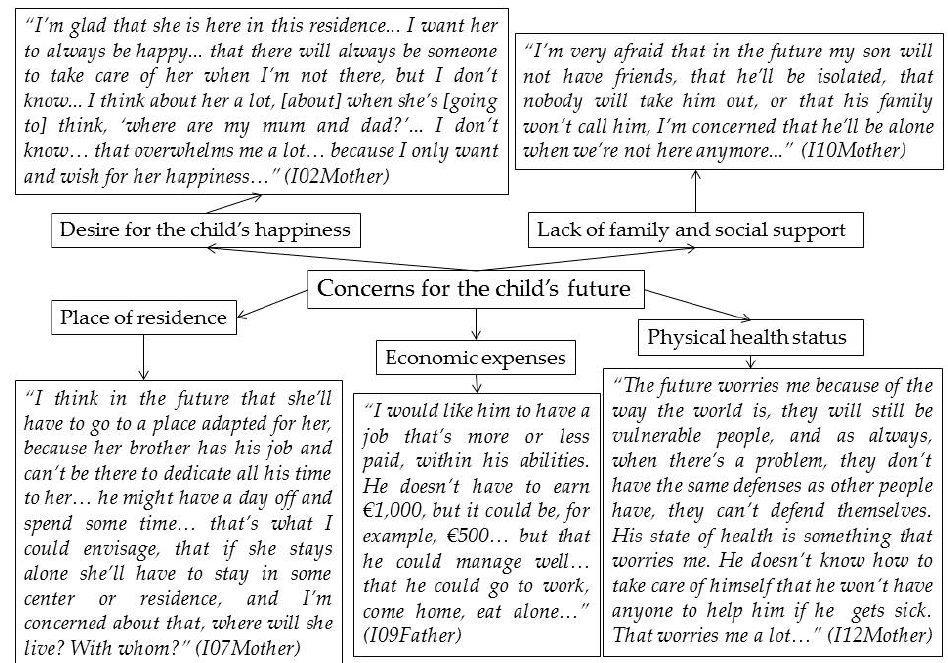
Figure 1. Quotations in Theme 4: Concerns about the future .